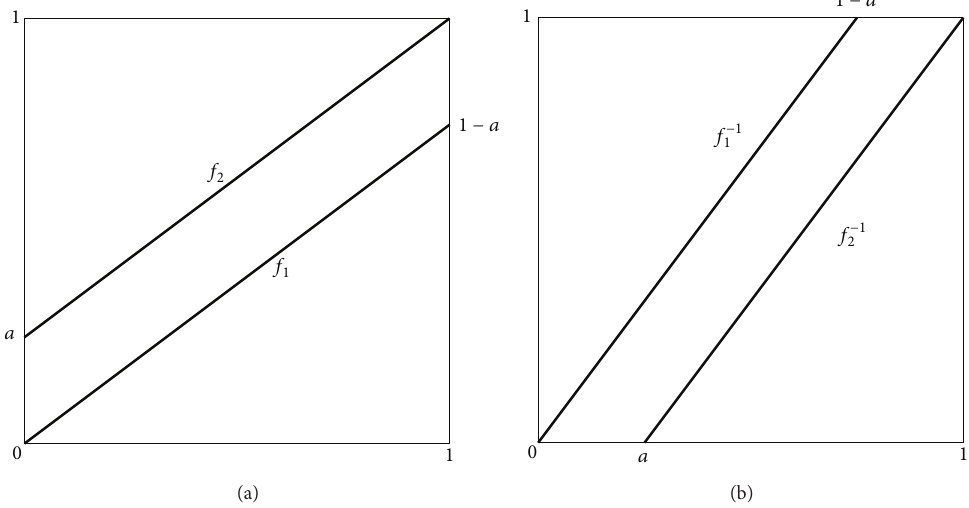
Figure 6: IFS equation (26) (a) and multivalued (without mask) dynamical system (coincides with 𝑆 ) connected with it (b).